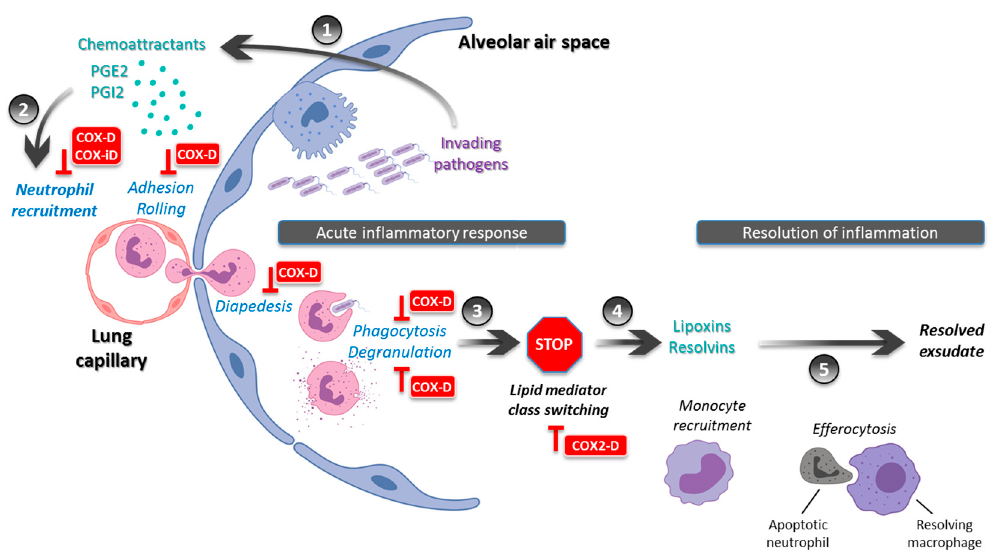
Figure 1. During pneumonia, NSAIDs may interfere with acute inflammation response and resolution. Invading pathogens within the alveolar air space induce an innate immune response, which involves cyclooxygenases (COX) to generate lipid mediators of inflammation such as prostaglandins (PG) E2 and I2 (1) . NSAIDs may alter the subsequent recruitment of polymorphonuclear neutrophils through both COX-dependent and COX-independent effects. NSAIDs also alter their intrinsic functions such as phagocytosis and degranulation (2) . The acute phase response is followed by a lipid mediator class switching (3) , which leads to the biosynthesis of pro-resolving mediators such as lipoxins and resolvins (4) . By inhibiting this stop signal through COX-2 inhibition, NSAIDs may limit the local recruitment of monocytes, which act through efferocytosis to resolve exudate, and subsequently hamper the resolution of inflammation (5) . Abbreviations: COX-D = Cyclooxygenase-dependent; COX-iD = Cyclooxygenase-independent; COX2-D = Cyclooxygenase 2-dependent. Adapted from Serhan et al. [34].